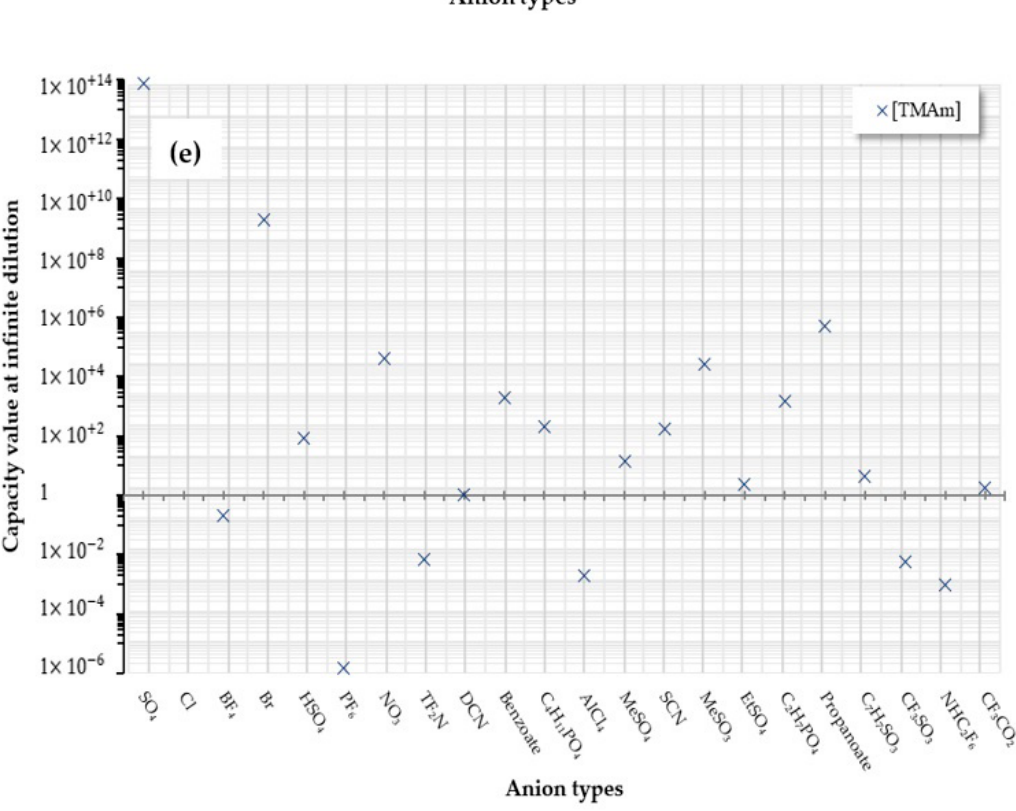
Figure 5. COSMO-RS-predicted infinite dilution capacity values (Y axis) of ILs including: ( a ) Imidazolium-, ( b ) Pyridinium-, ( c ) Pyrrolidinium-, ( d ) Piperidinium- and ( e ) Teramethyl ammonium-based cation alkyl chain lengths with 22 anions (X axis) at 25 °C for DHA extraction.